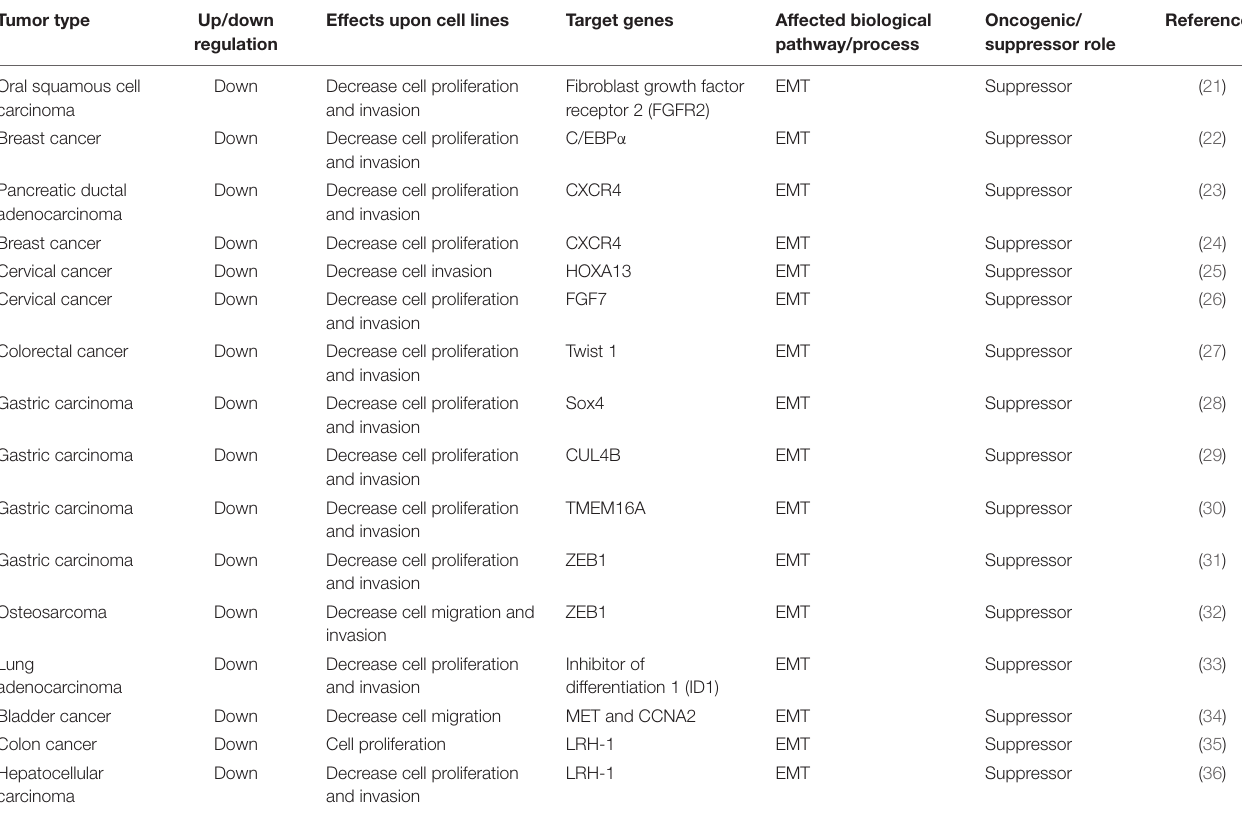
TABLE 2 | MiR-381 participates in epithelial–mesenchymal transition (EMT)